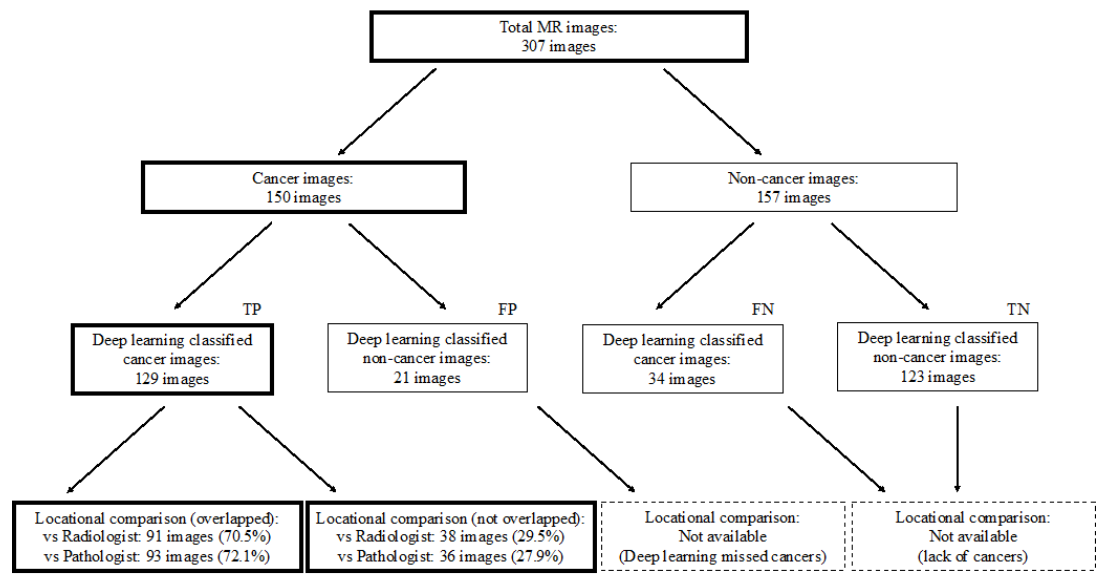
Figure 2. Study profile. TP = true positive, FP = false positive, FN = false negative, TN = true negative.